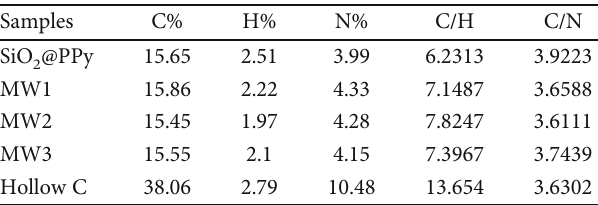
Figure 4: TEM images of SiO @C NPs (a – c) and Hollow C (d – f). (b) The circled part shows one of the cores lose its shell during the reaction. 2 Table 2: EA results of SiO @PPy, samples after microwave, and 2 Hollow